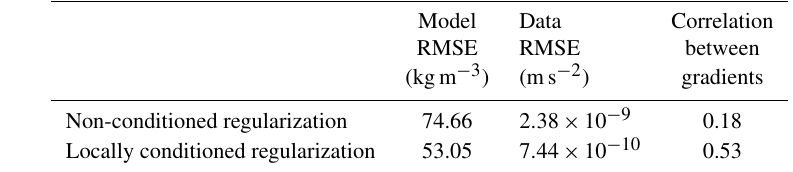
Table 1. Indicators for comparison of inversion results in terms of model, data and structure.